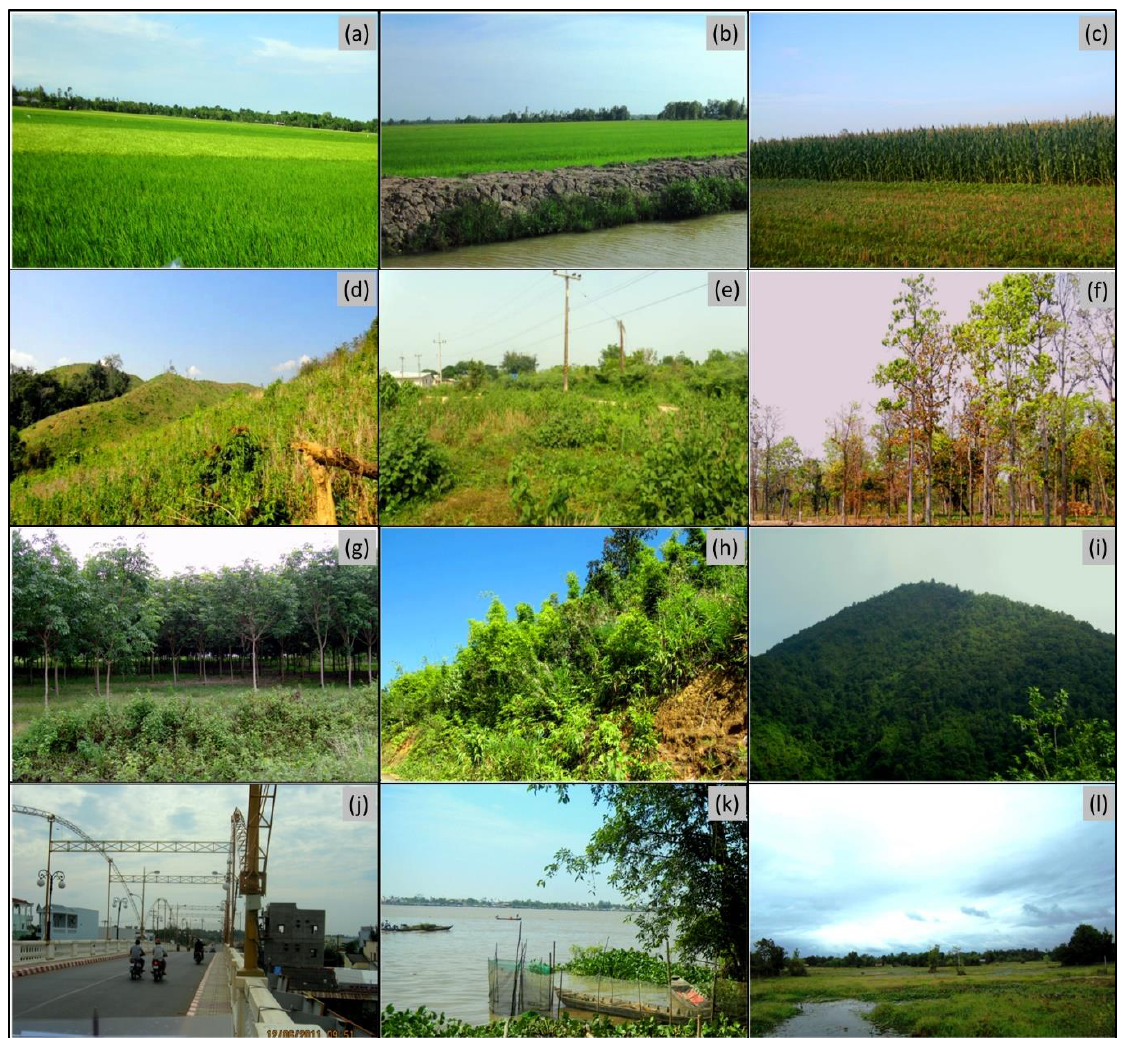
Figure 3. Example Land Use Land Cover (LULC) classes occurring in SBs 1 – 8 of the lower Mekong Basin (LMB): ( a ) rainfed rice; ( b ) irrigated double-cropped rice; ( c ) mixed annual crops other than rice; ( d ) shifting cultivation areas; ( e ) shrubland; ( f ) deciduous forest; ( g ) industrial forest plantation (e.g., rubber); ( h ) bamboo scrub/forest; ( i ) evergreen broadleaved forest; ( j ) urban areas; ( k ) water bodies; and ( l ) wetlands. The above imagery was provided to project by the Mekong River Commission